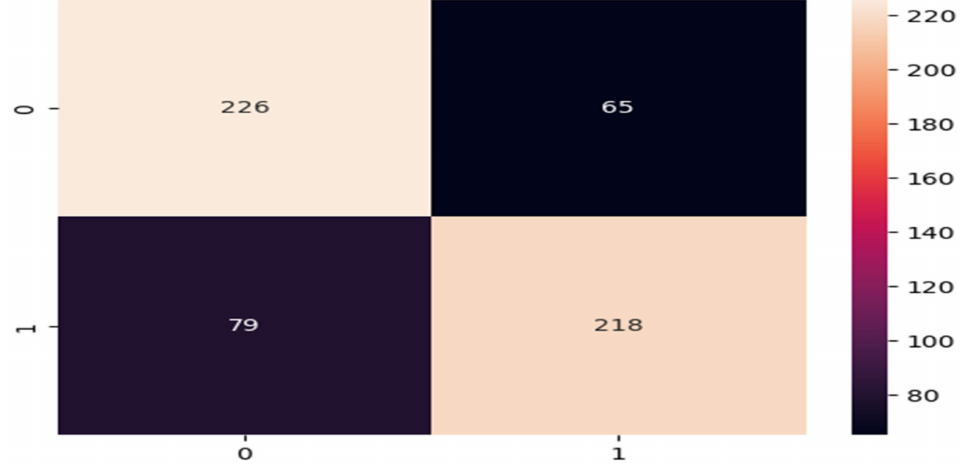
Figure 15. Confusion matrix of VGG-16 with gradient boosting.